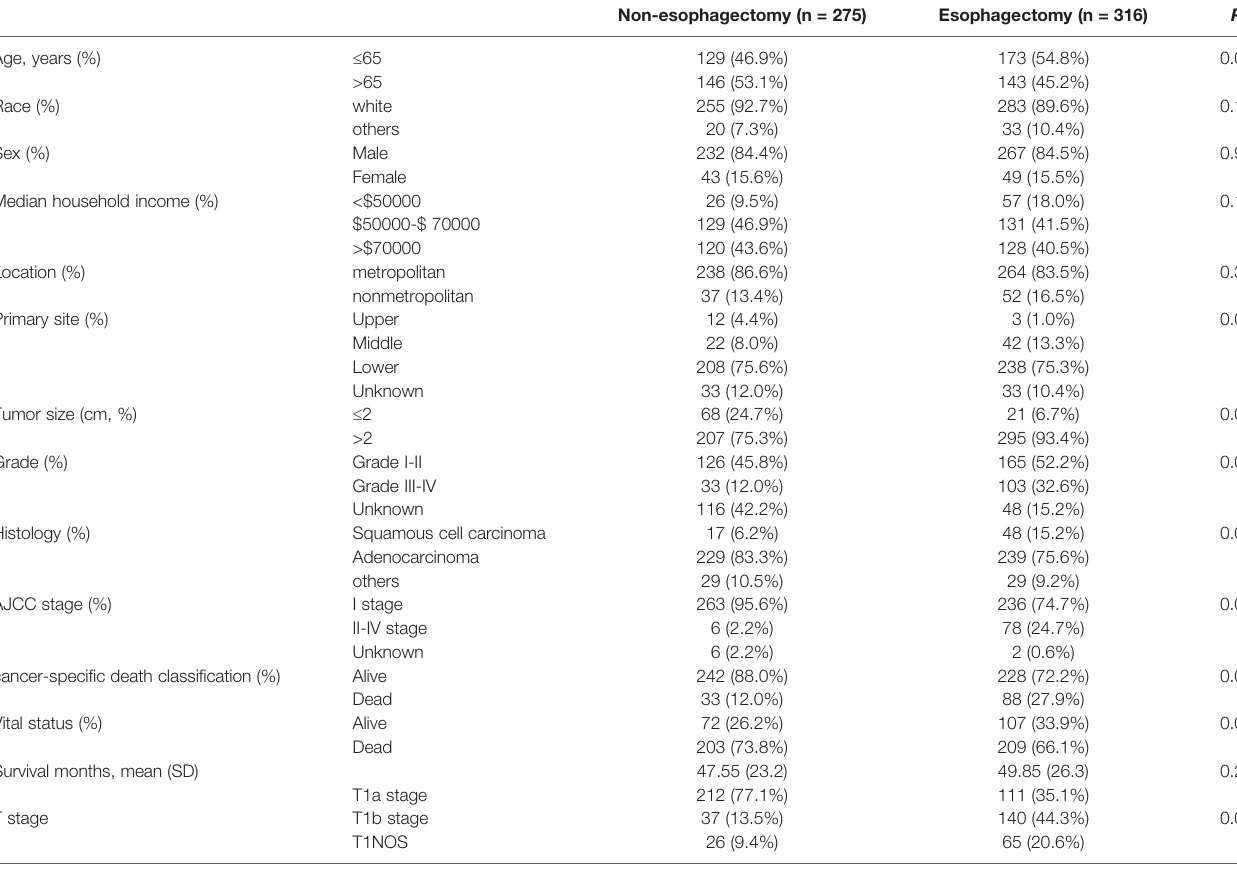
TABLE 1 | Baseline characteristics of T1 stage esophagus cancer patients with or without esophagectomy between 2005-2015. Non-esophagectomy (n = 275) Esophagectomy (n = 316)